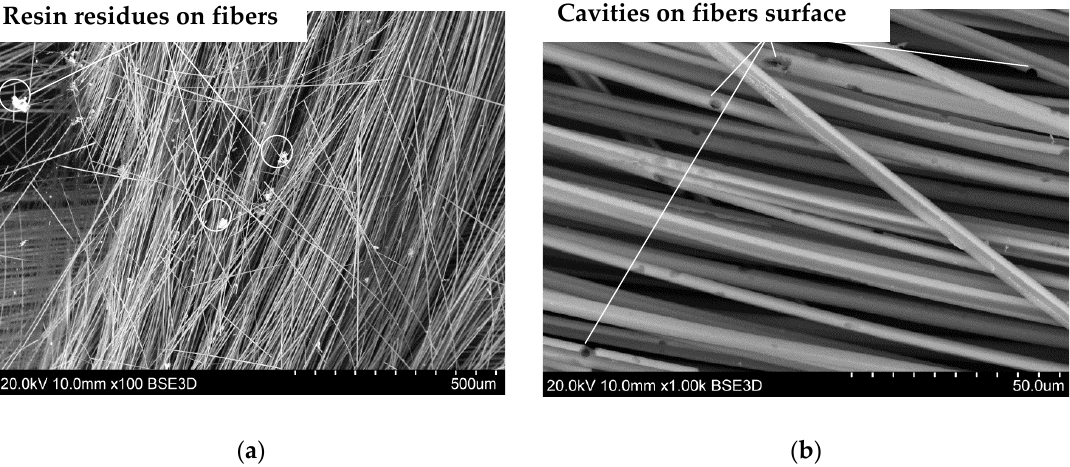
Figure 4. ESEM images of fiber surface ( a ) with resin residues, ( b ) with traces of damage.